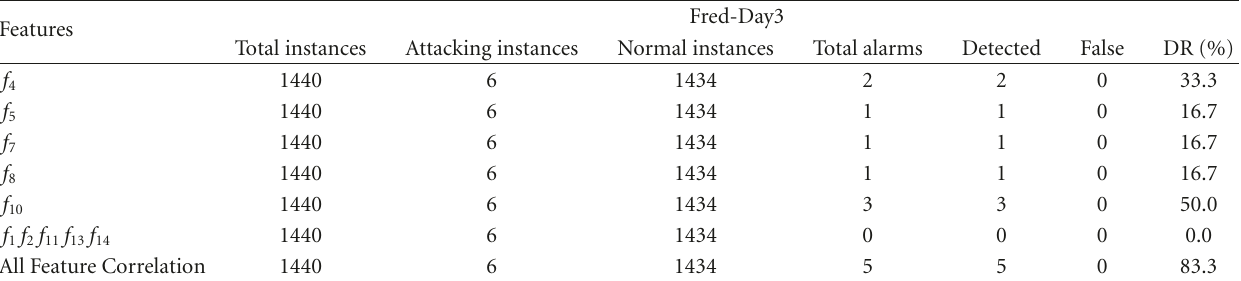
Table 12: Number of attack instances detected for each feature and all features correlation for Fred-Day3.